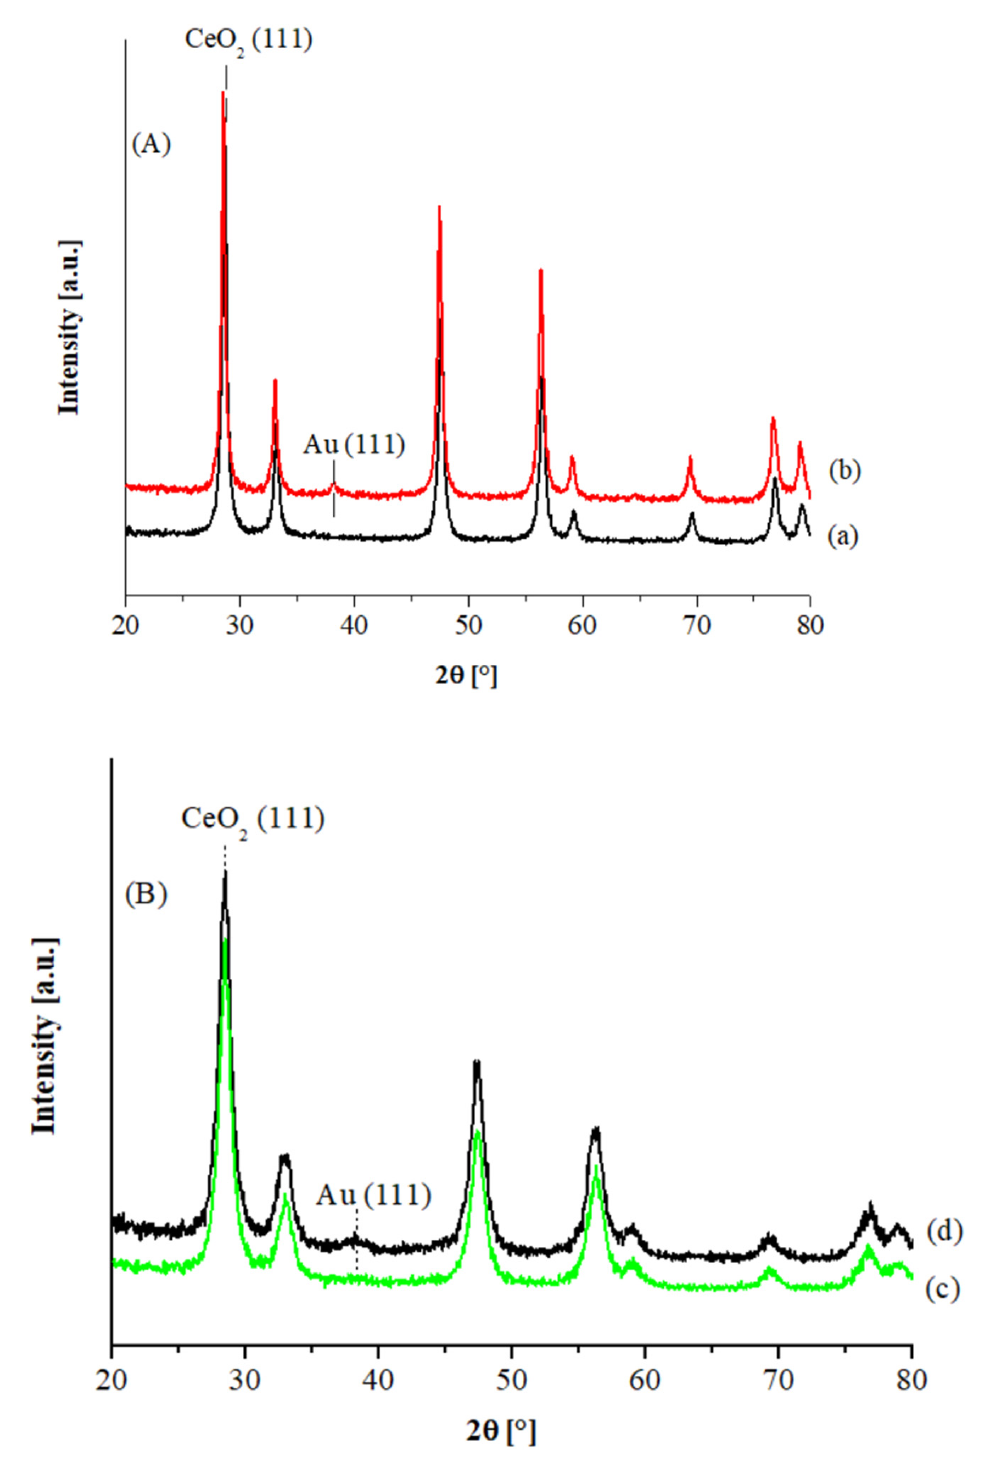
Figure 1. XRD patterns of: ( A ) Au/CeO 2 Aldrich: (a) 1%Au/CeO 2 A, (b) 3%Au/CeO 2 A; ( B ) Au/CeO 2 home prepared: (c) 1%Au/CeO 2 hp; (d) 3%Au/CeO 2 hp.